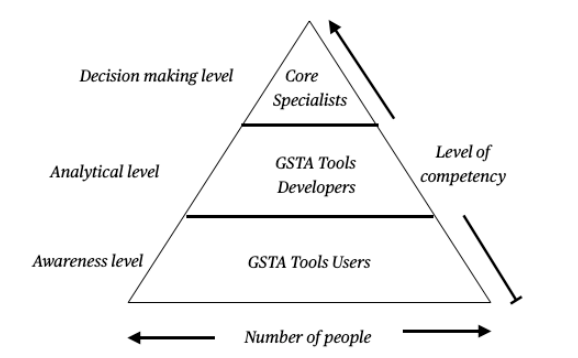
Figure 1 . Users and levels of